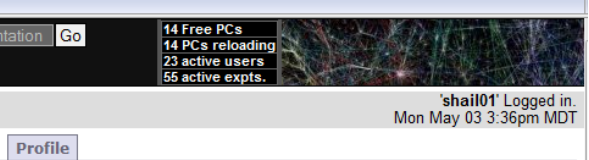
Fig. 9: More resources available with deletion of more slices.